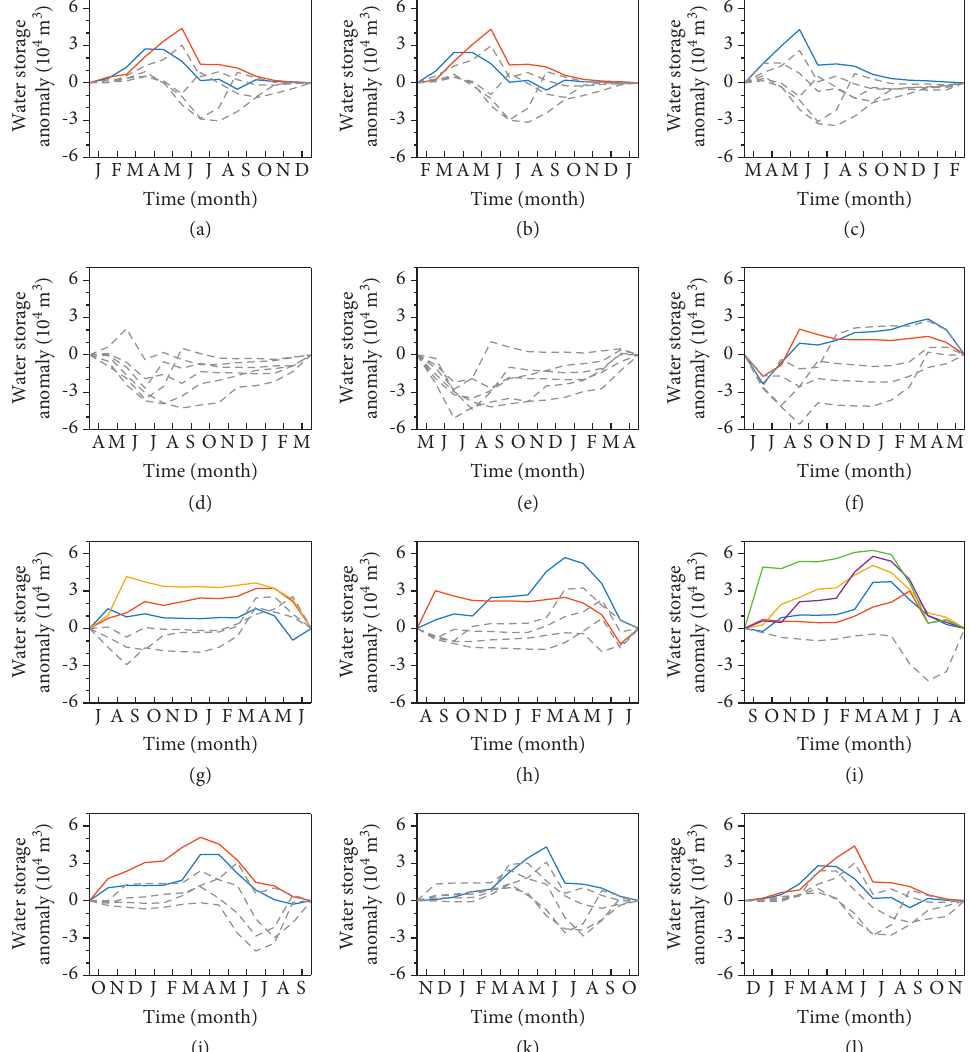
Figure 4: Water storage anomaly for different 12-month regulating cycles in historical time (1969–2008). The curves for damage years (negative storage anomaly for more than two months) are shown by gray dash lines while undamaged years by color solid lines (colors are only used to distinguish multiple lines). (a–l) Regulating cycles start from January to December. Table 4: Six representative hydrological years under different regulation cycles. Regulation cycle